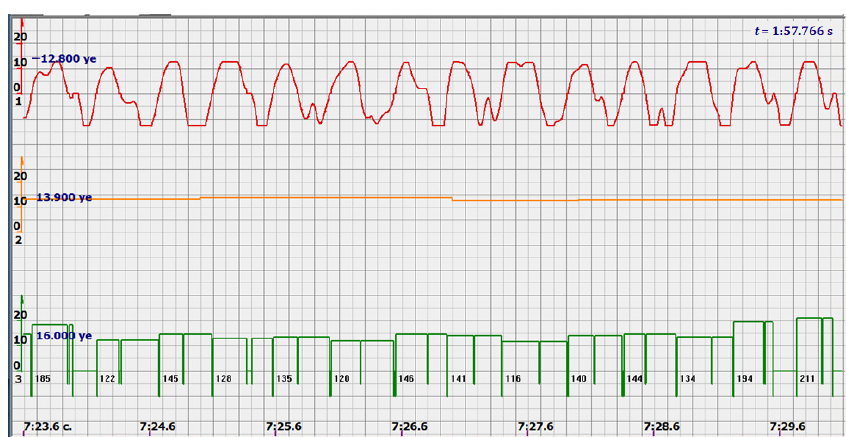
Figure 18. Heart rate—from 122 to 150 bpm.